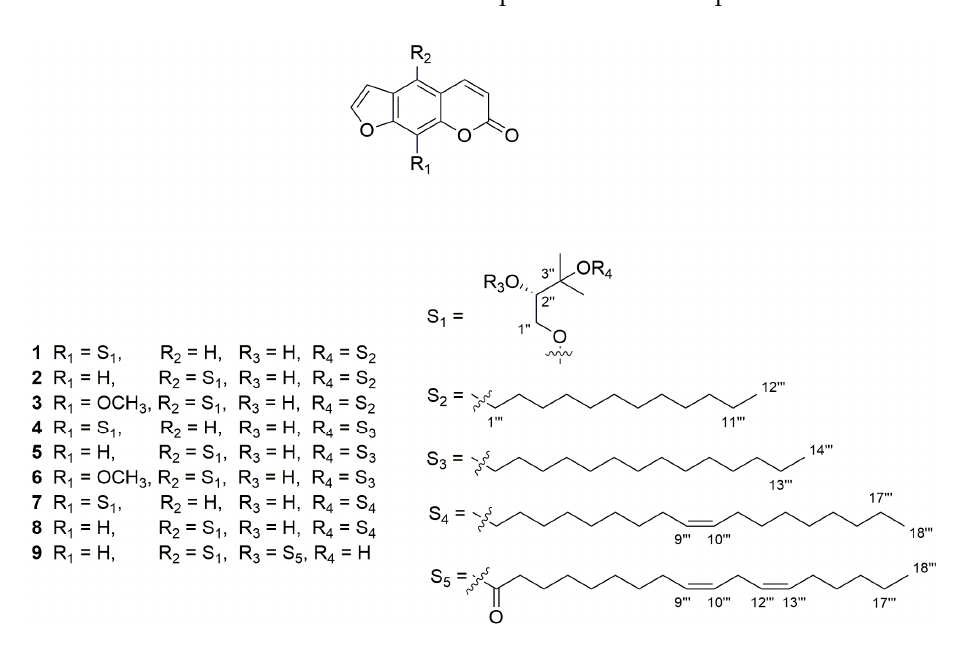
Figure 1. The structures of nine furanocoumarins isolated from Hangbaizhi collected from the Yangtou Village of Shenze Township in Pan’an county of Zhejiang province of China. From 1 to 9 , they are andafocoumarins A, B, C, D, E, F, G, H, and J.